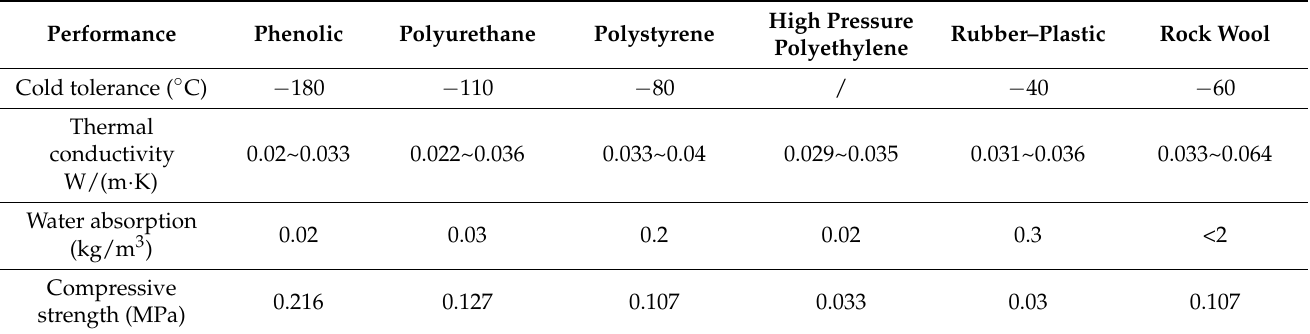
Table 7. Performance of insulation materials.